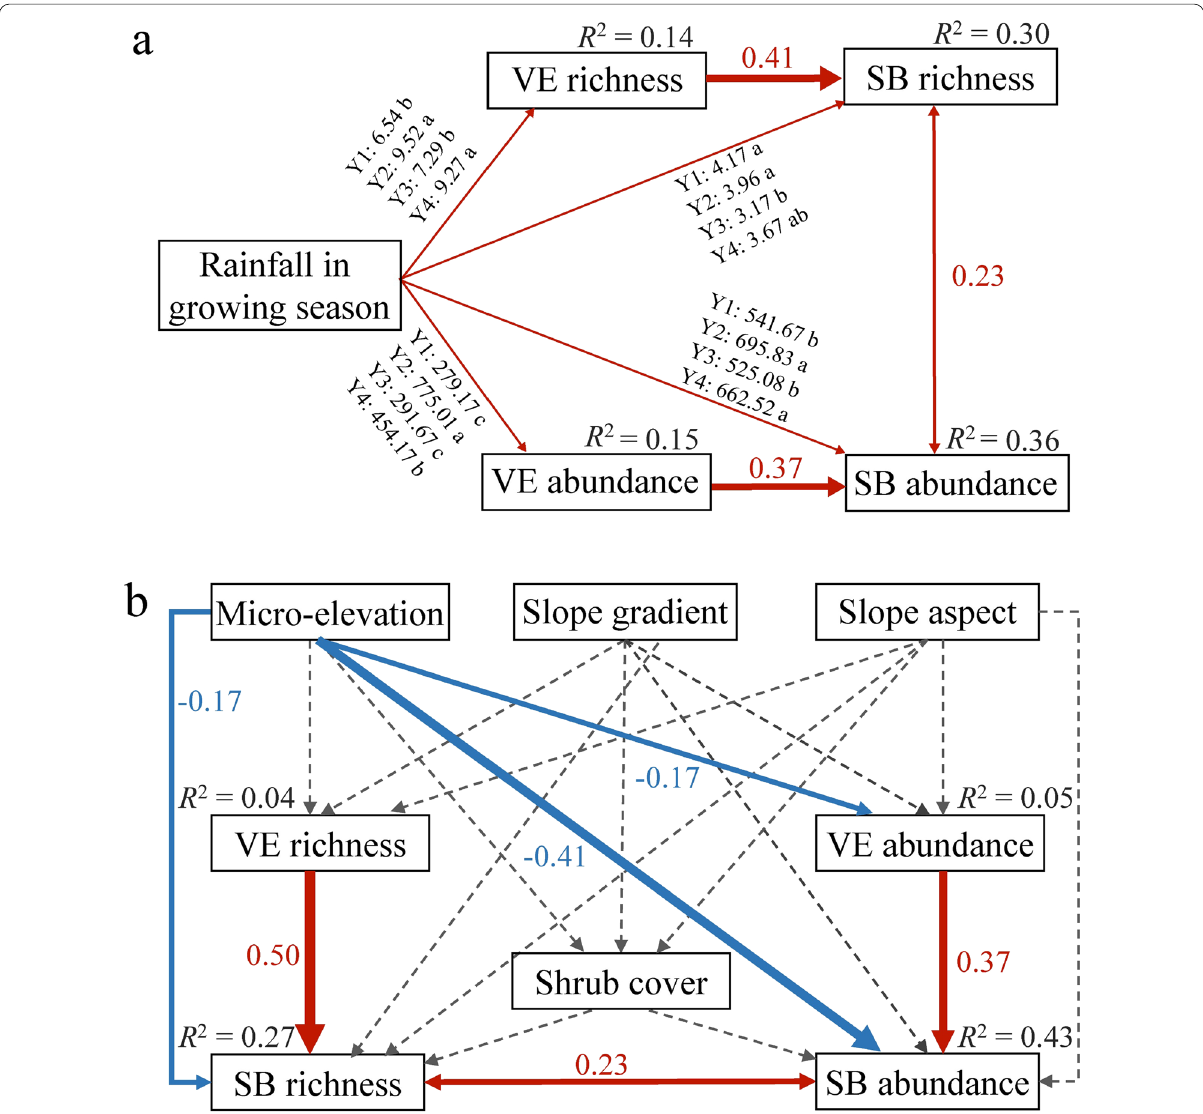
Fig. 2 a First structural equation model (SEM) linking rainfall in the growing season to species richness (VE richness) and abundance (VE abundance) of the aboveground vegetation and to species richness (SB richness) and abundance (SB abundance) of the soil seed bank in each quadrat. b Second SEM linking microtopographic conditions to species richness and abundance of aboveground vegetation, and shrub coverage to species richness and abundance of the soil seed bank. Red, blue and dotted arrows represent significant positive, negative and nonsignificant effects at 0.05 level, respectively ( n 148). Numbers indicate the significant standard path coefficients and the thickness of the colored arrows = reflects its relative magnitude. Letters a – c in the above figure denote groupings via post‑hoc tests. Multiple R 2 is displayed at the top of